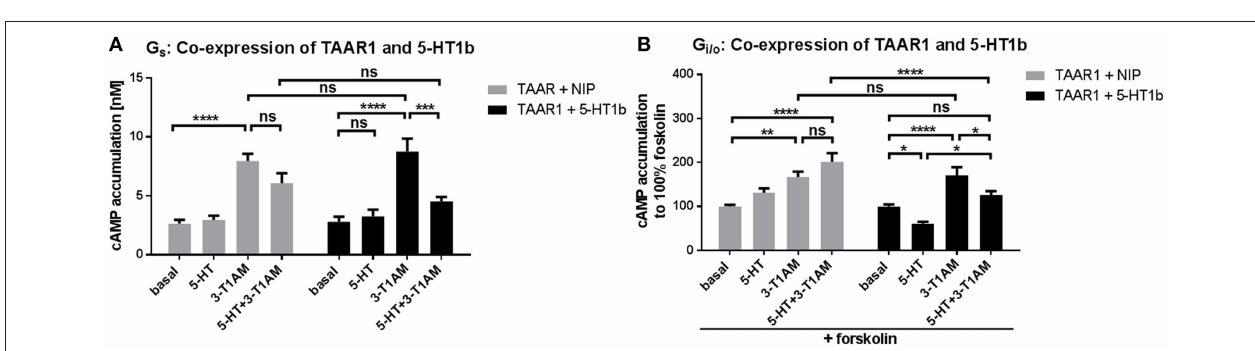
FIGURE 4 | TAAR1 and 5-HT1b can interact. Sandwich ELISA and FRET were performed to investigate dimerization. (A) For sandwich ELISA, receptor pairs were overexpressed in COS-7 cells, receptors were NHA- and FLAG-tagged and vice versa . The homodimers GHSR and TAAR1, as the heterodimer TAAR1 and DRD2 were used as positive control; TAAR1 and rM3R were used as negative control. NHA control are cells over expressing NHA-tagged TAAR1, 5-HT1b, DRD2, and GHSR. Data are shown as mean ± SEM of fold over mock transfection. Data were pooled from four to eight independent assays measured in three replicates. For statistical analysis, a one-way ANOVA was performed in relation to mock transfection. (B) To determine FRET efficiency, HEK293 overexpressed receptor pairs, one being CFP and one the YFP tagged and vice versa . The heterodimer GHSR and MC3R was used as positive control, CB1R and MC3R as negative control. rM3R was used as NIP for TAAR1. Compared to GHSR and MC3R dimers, the negative control and TAAR1 with the NIP showed no protein-protein-interactions, whereas TAAR1 and 5-HT1b co-expression did. Data were pooled from 11 to 19 cells and a one-way ANOVA was performed and the mean of each column was compared with the mean of all other columns. Statistical significance was defined as * p ≤ 0.05, ** p ≤ 0.01, **** p ≤ 0.0001.